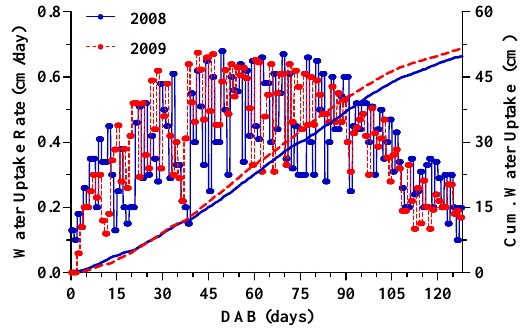
Figure 4. Simulated actual daily water uptake rate and cumulative root water uptake during the 2008 and 2009 seasons.